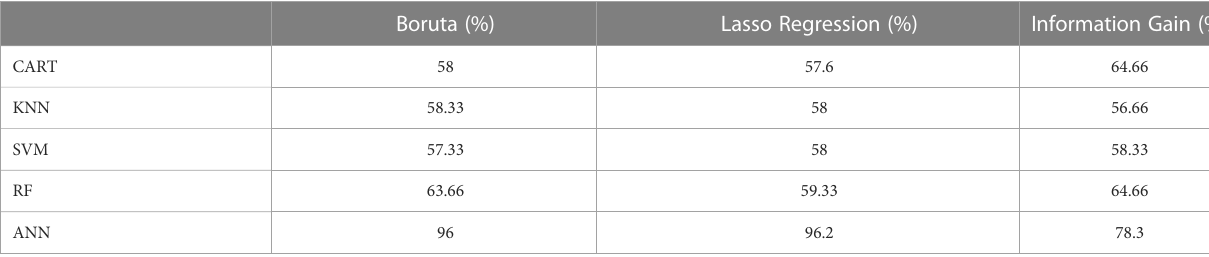
TABLE 2 Benchmarking different classi fi cation algorithms.